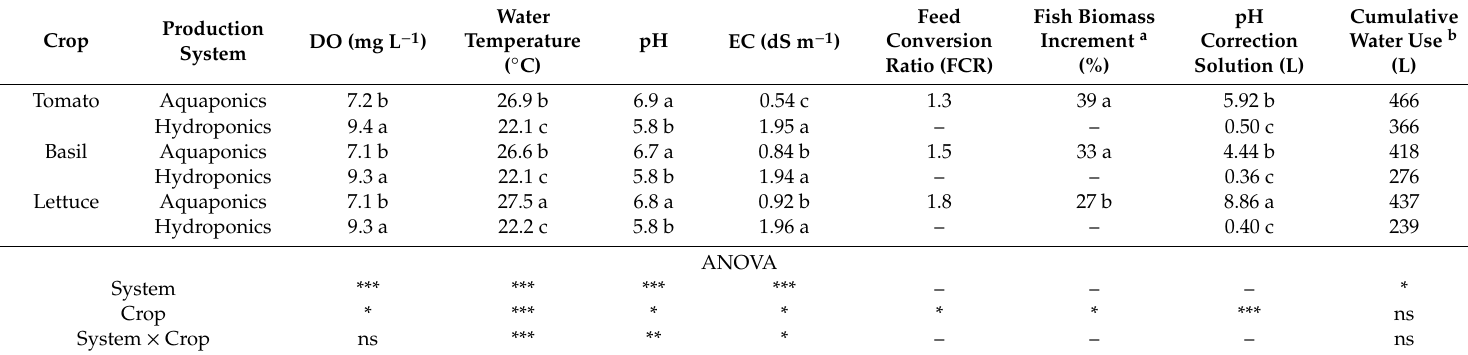
Table 3. Average water quality parameters, fish biomass increment, and cumulative water use of tomato-, basil-, and lettuce-based aquaponic and hydroponic systems during a 3-month production.